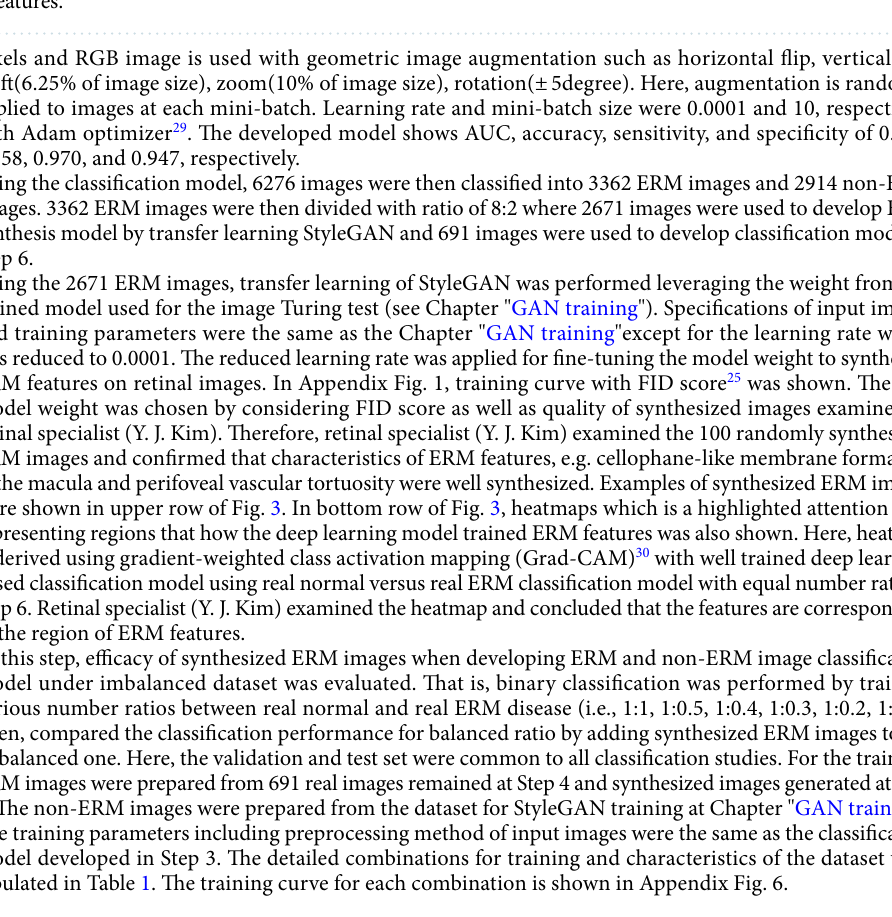
Figure 3. Representative randomly synthesized images demonstrating ERM. Cellophane-like membrane formation at the macula and perifoveal vascular tortuosity are shown in synthetic fundus images. Heatmap derived using Grad-CAM (https:// github. com/ jacob gil/ pytor ch- grad- cam) correspond to these characteristic ERM